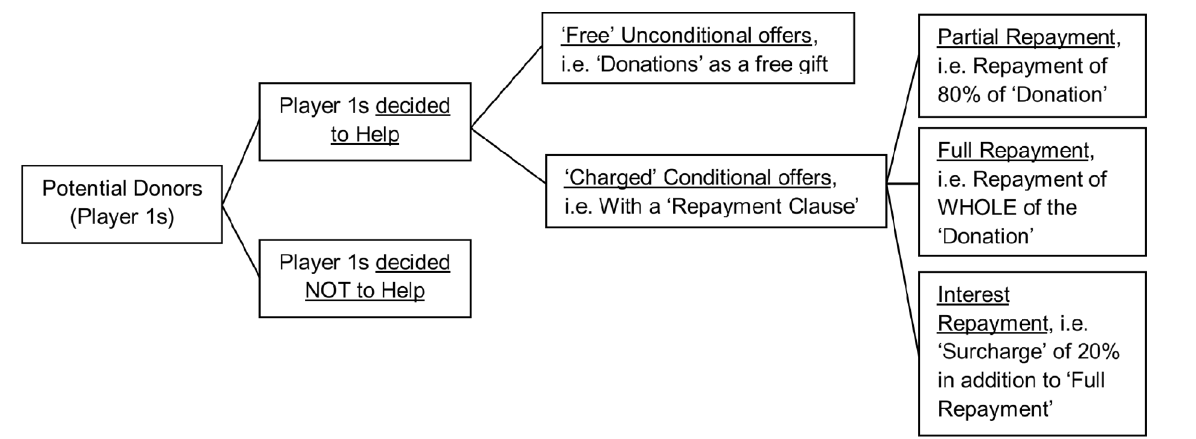
Fig. 1. The flow of decisions made by a potential helper (Player 1).